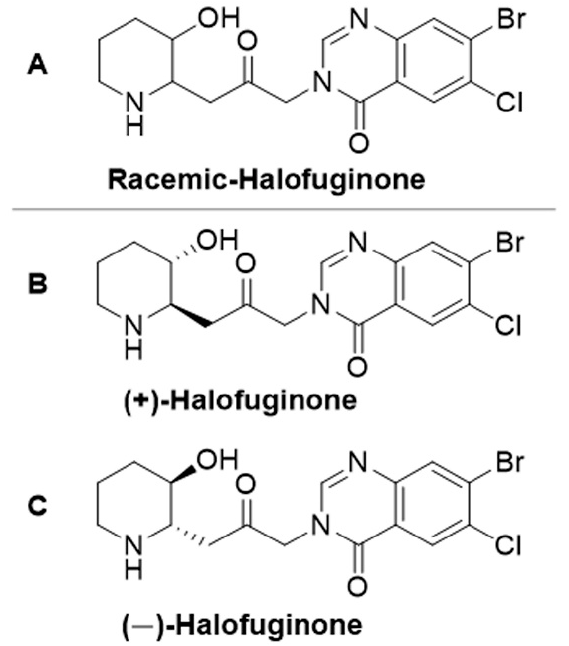
Figure 1. Schematic representation of racemic halofuginone ( A ) and its optical enantiomers (+)-halofuginone ( B ), and ( − )-halofuginone ( C